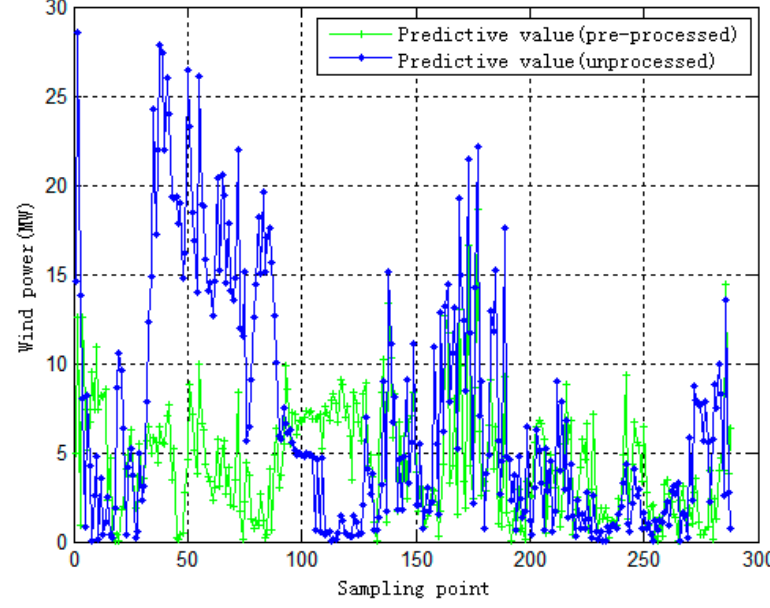
Figure 12. The comparison of the error of the two cases.